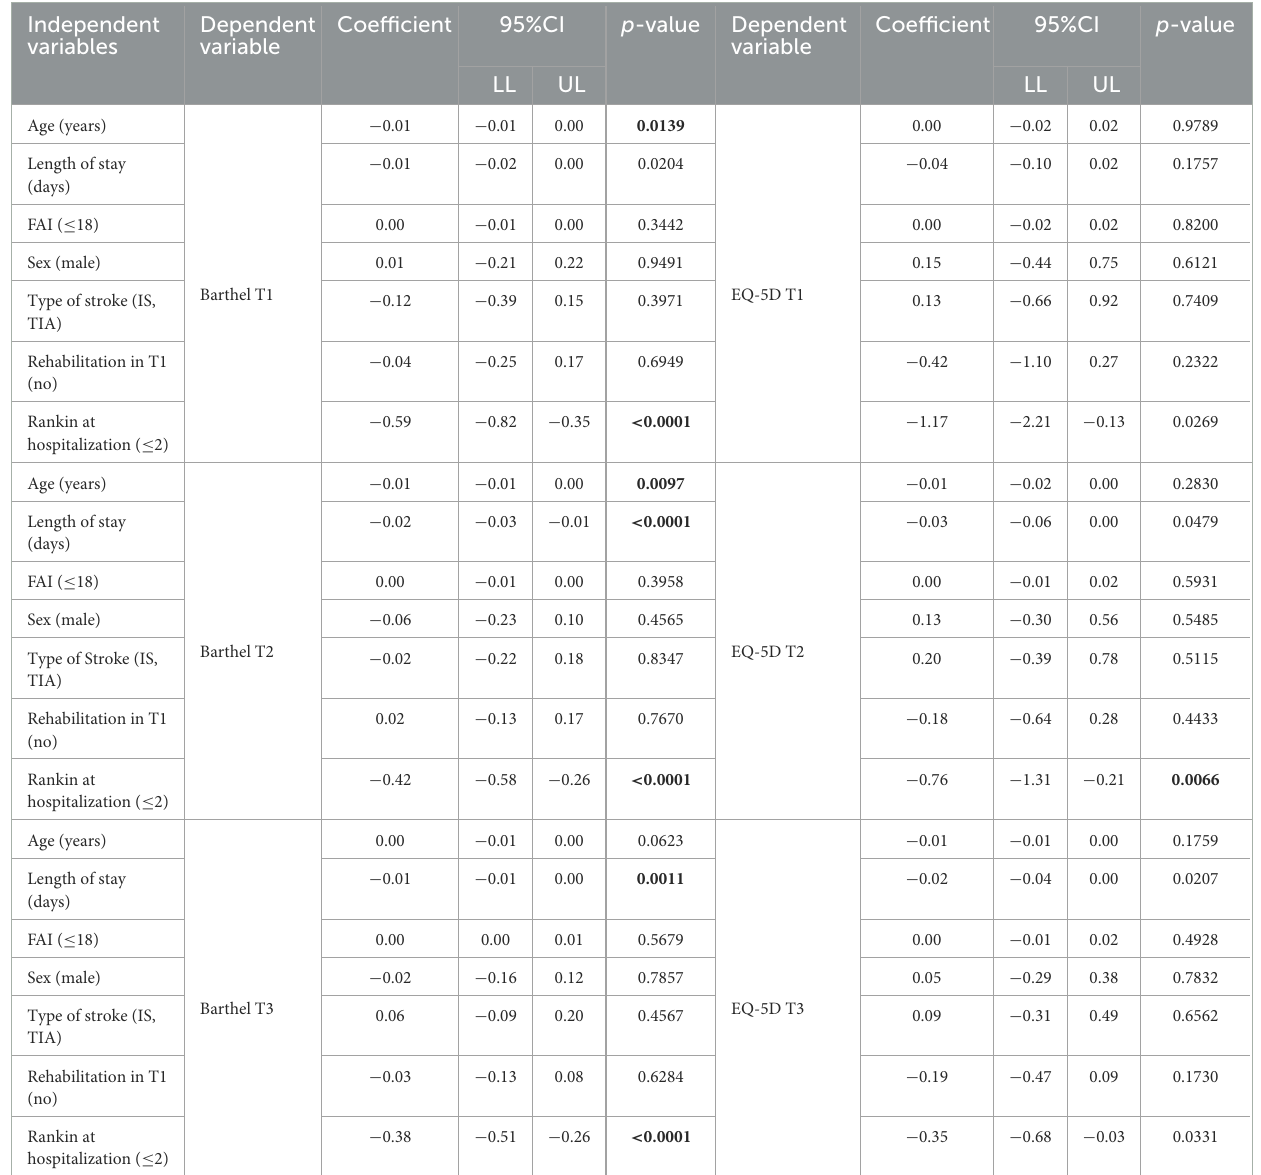
TABLE 4 Multiple regression